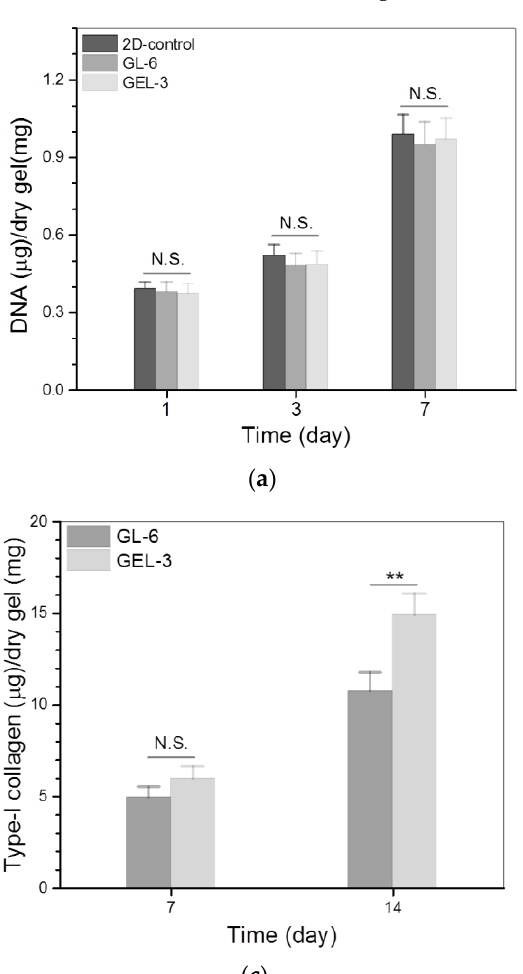
Figure 8. Proliferation ( a ), ALP activity ( b ) and type-I collagen deposition ( c ) of MC3T3-E1 cells growing inside gels (**, p < 0.01; N.S., not significant).